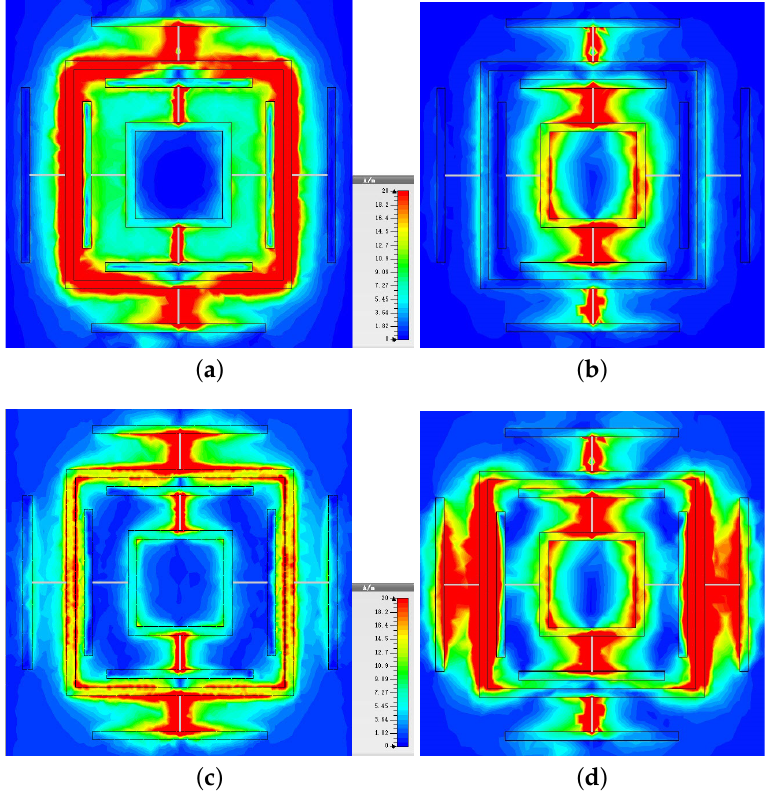
Figure 3. Surface current loss distribution of the proposed absorber, at the absorption peaks of ( a ) 2.91 GHz, ( b ) 4.06 GHz, ( c ) 6.79 GHz, and ( d ) 9.6